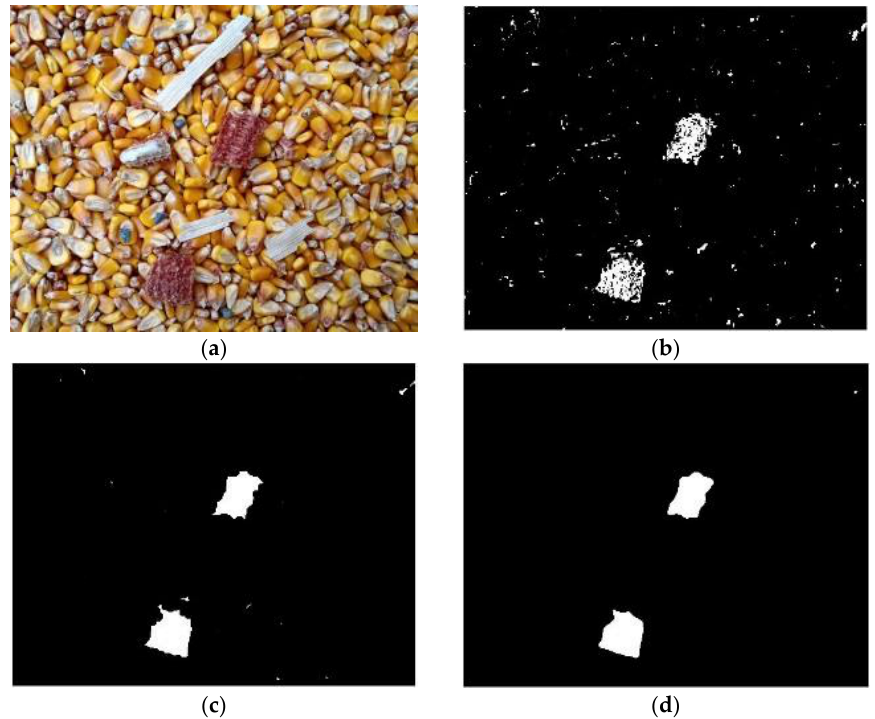
Figure 8. Identification of broken corncobs. ( a ) Original image 3 of corn, ( b ) Coarse extraction of broken corncobs impurities, ( c ) Close operation, ( d ) Broken corncobs impurities.